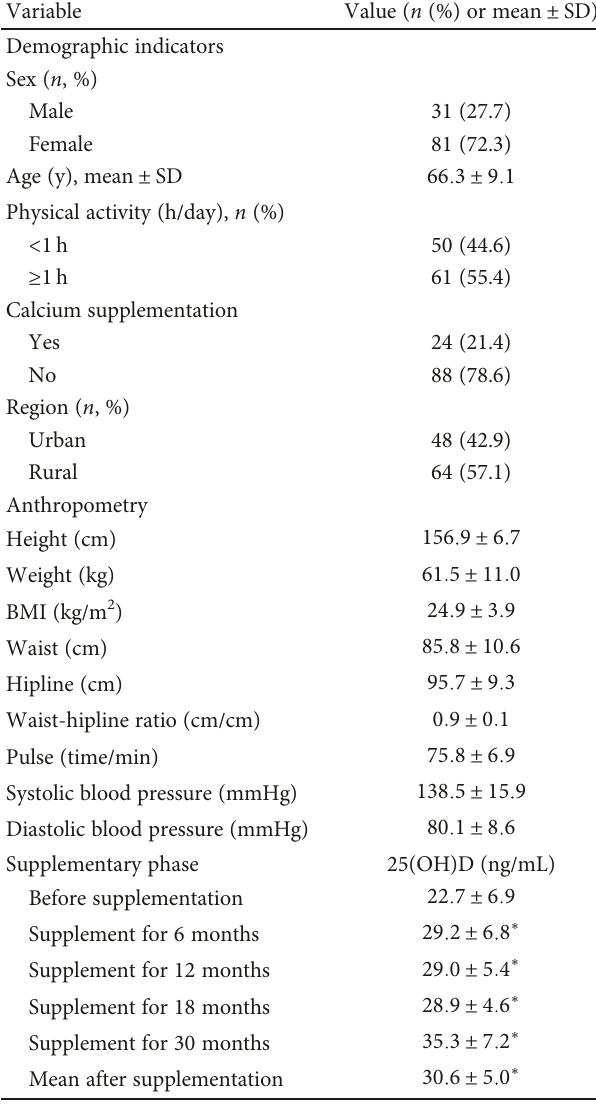
Table 1: Basic characteristics of diabetic